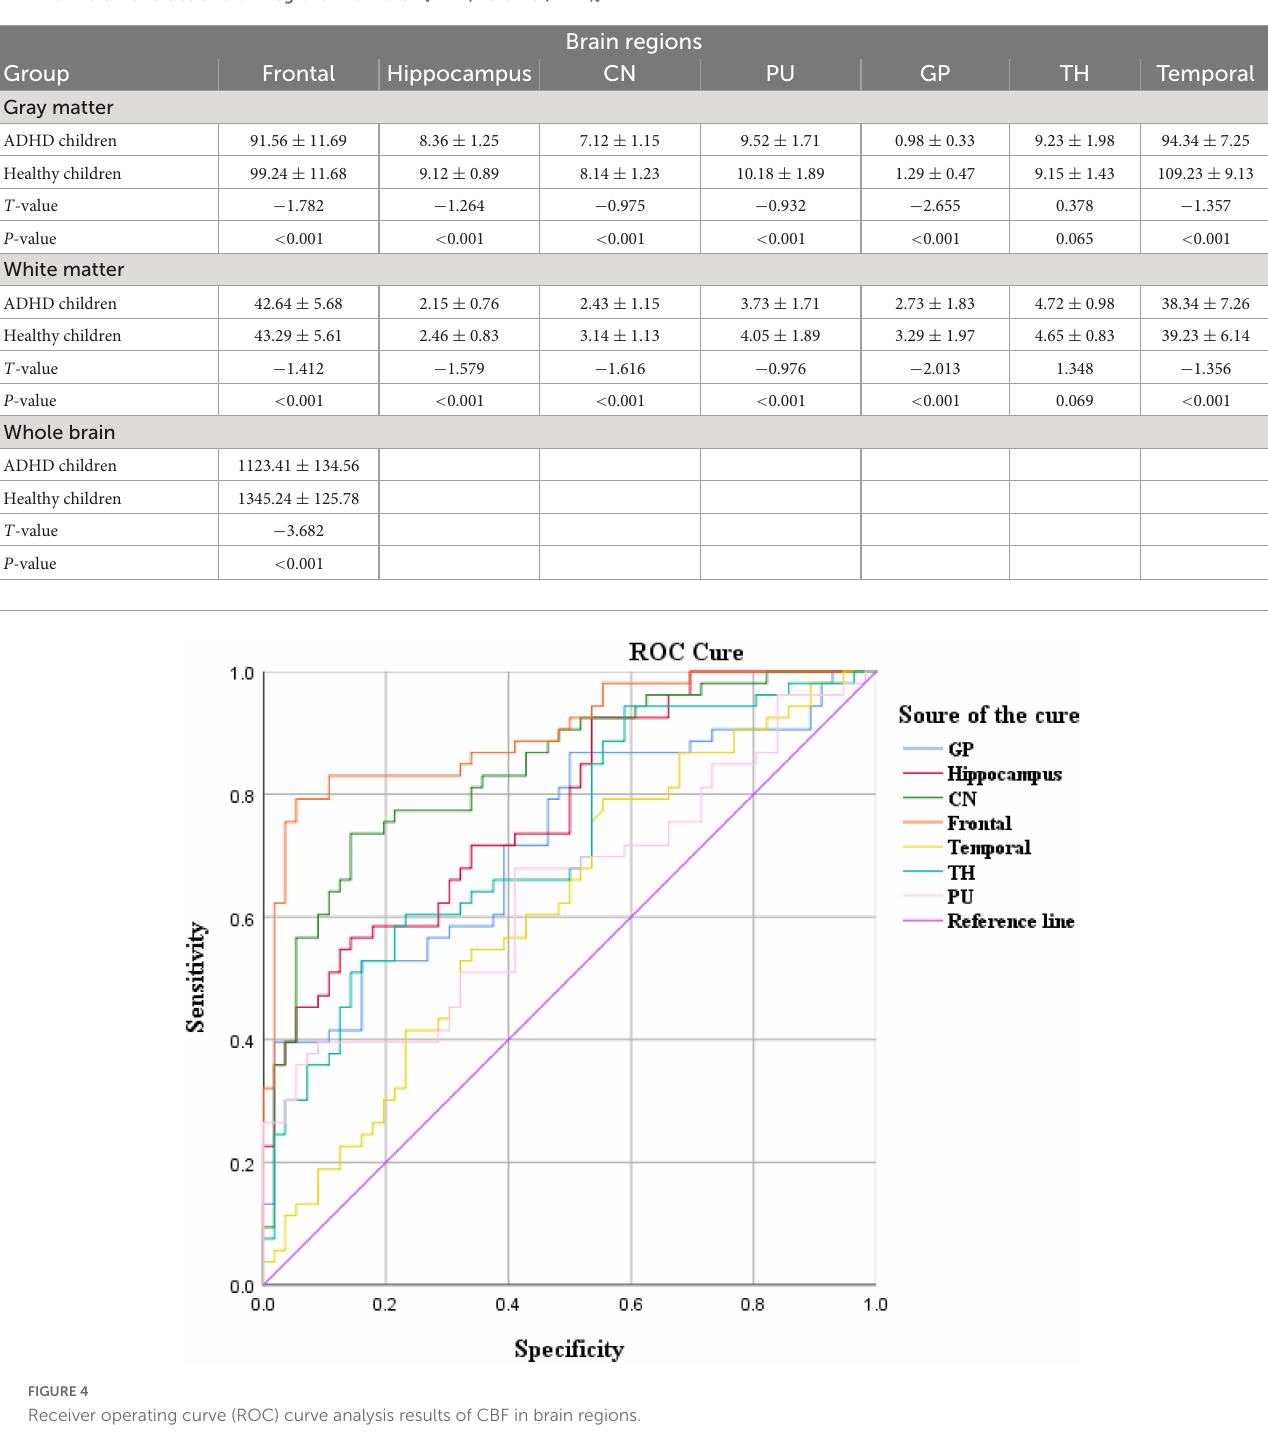
TABLE 3 Volume values of brain regions in children [ x ± s, volume (mm 3 )].